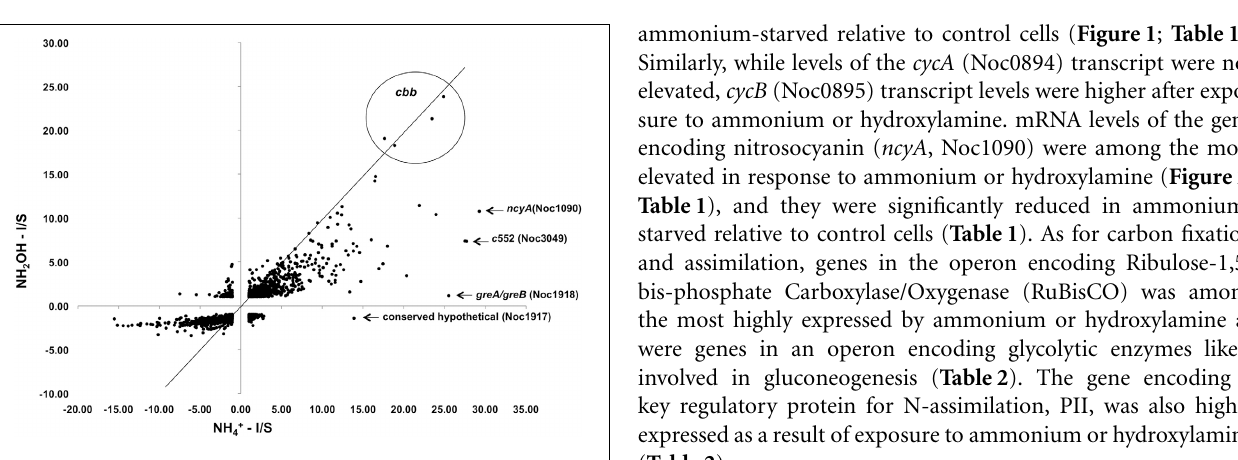
Data from RT-qPCR assays presented in Table 1 were per- formed using the same RNA preparations as for microarray hybridizations, employing primer sets designed against